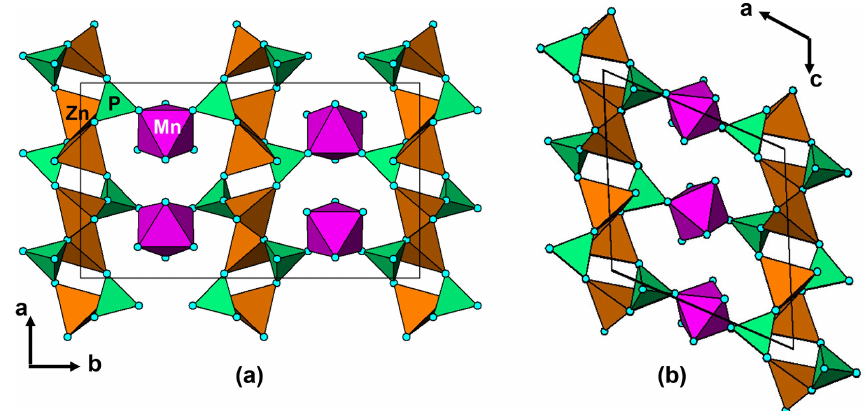
Figure 12. (a) A [001] projection of the structure of nizamoffite compared to (b) a [010] projection of the structure of steinmetzite, showing the (010) layers of corner-connected tetrahedra of composition [Zn(PO 4 ) 2 ] that are common to both structures and the different types of linkage of the layers with corner-connected octahedra